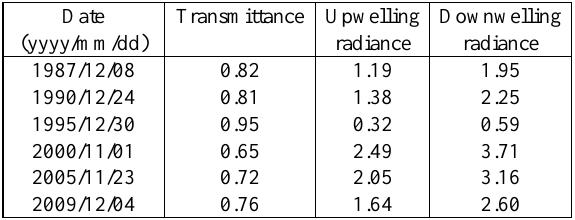
Table 2. Atmospheric correction parameter (4) Surface